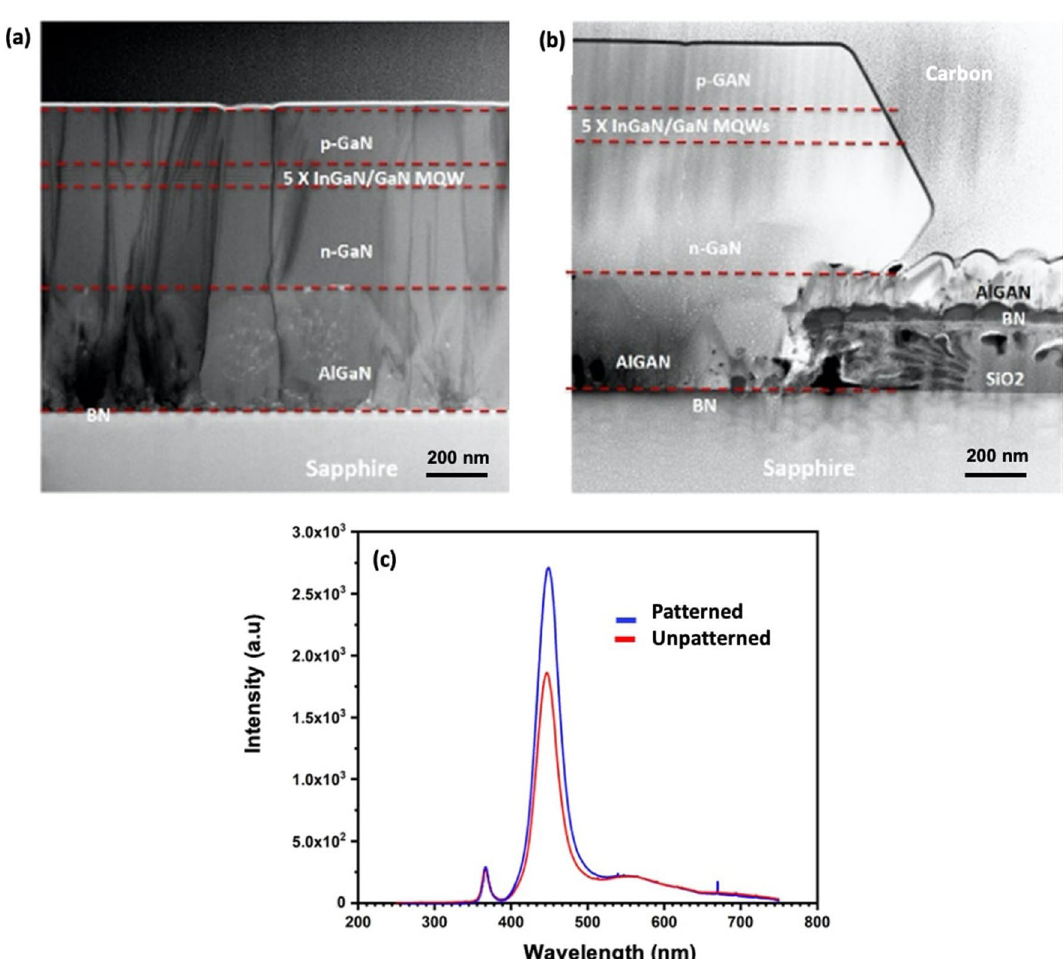
Figure 3. ( a ) TEM image of the unpatterned sample, ( b ) TEM image of the patterned sample, ( c ) cathodoluminescence spectra at 8 kV recorded on both structures at room temperature. Both spectra have been normalized with respect to their GaN peak